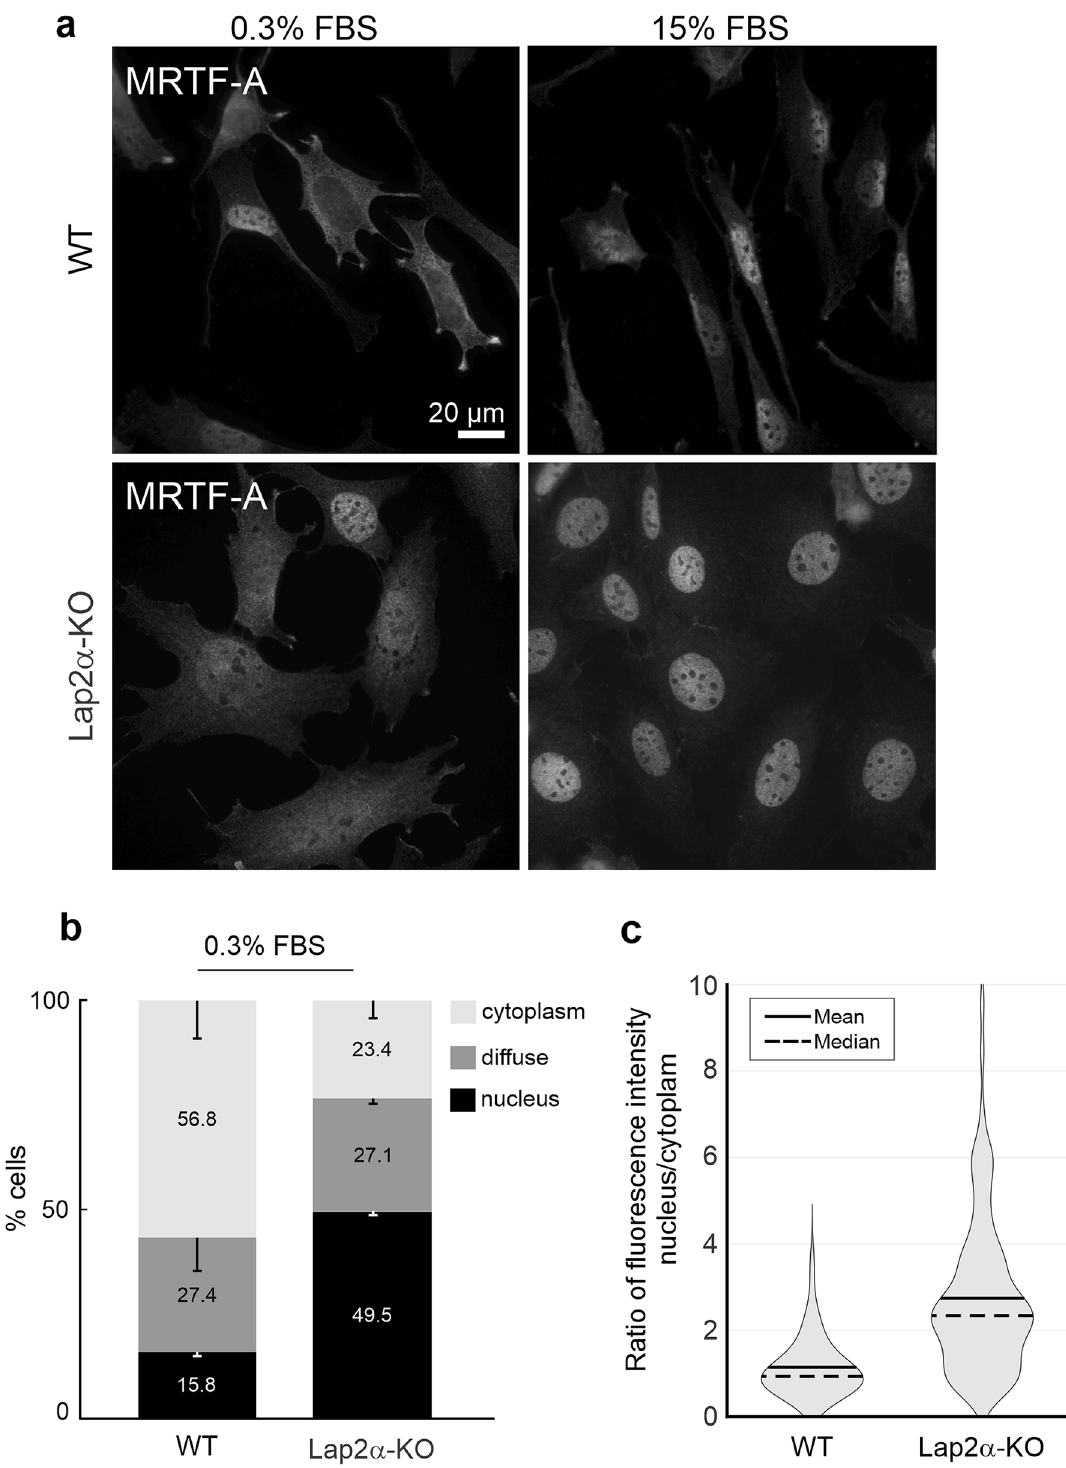
Figure 3. Lap2α is not required for MRTF-A nuclear localization. (a) MRTF-A localization in Lap2α WT and KO MDFs in serum starved (0.3% FBS) cells and after 10 min stimulation with 15% FBS. scale bar = 20 µm. (b) Quantification of MRTF-A localization in Lap2α WT and KO MDFs in serum-starved conditions (0.3%). Cells were counted in three independent experiments; total number of counted cells: for WT 395; for KO 412. Statistically significant differences (*; P < 0.01) tested by Student’s t -test P -values: WT nucleus vs KO nucleus 2.47 × 10 –4 ; WT cytoplasm vs KO cytoplasm 3.57 × 10 –3 . (c) Fluorescence intensity ratio between the nucleus and the cytoplasm for endogenous MRTF-A in WT and Lap2a KO MDF cells under starved conditions (0.3% FBS). Violin plot showing distribution of cells according to the intensity ratio (nuc/cyt). For WT: n = 117, mean = 1.147, median = 0.936, s.d. = 0.64. For KO: n = 92, mean = 2.745, median = 2.344, s.d. = 1.763. See also